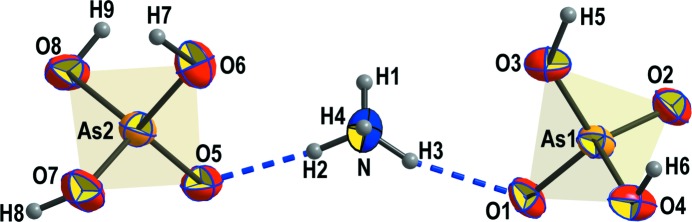
The principal building unit of (NH4)(H2AsO4)(H3AsO4), shown as dis­placement ellipsoids at the 70% probability level. Hydrogen bonds are shown as blue dashed lines.